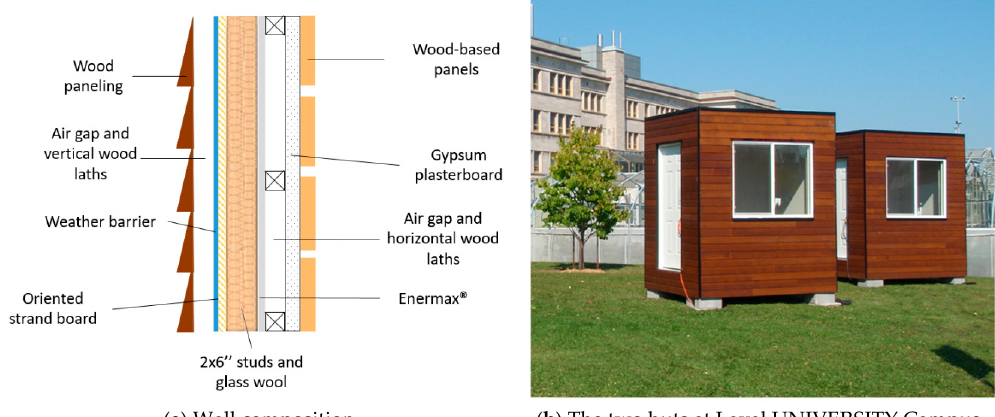
Figure 3. Description of the test huts.